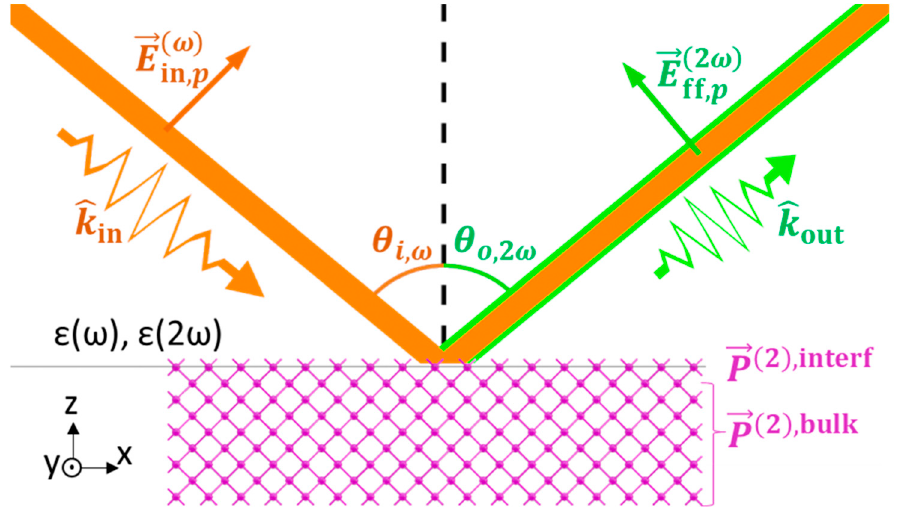
Figure 1. Geometry of fundamental and RSHG waves in the material of interest.